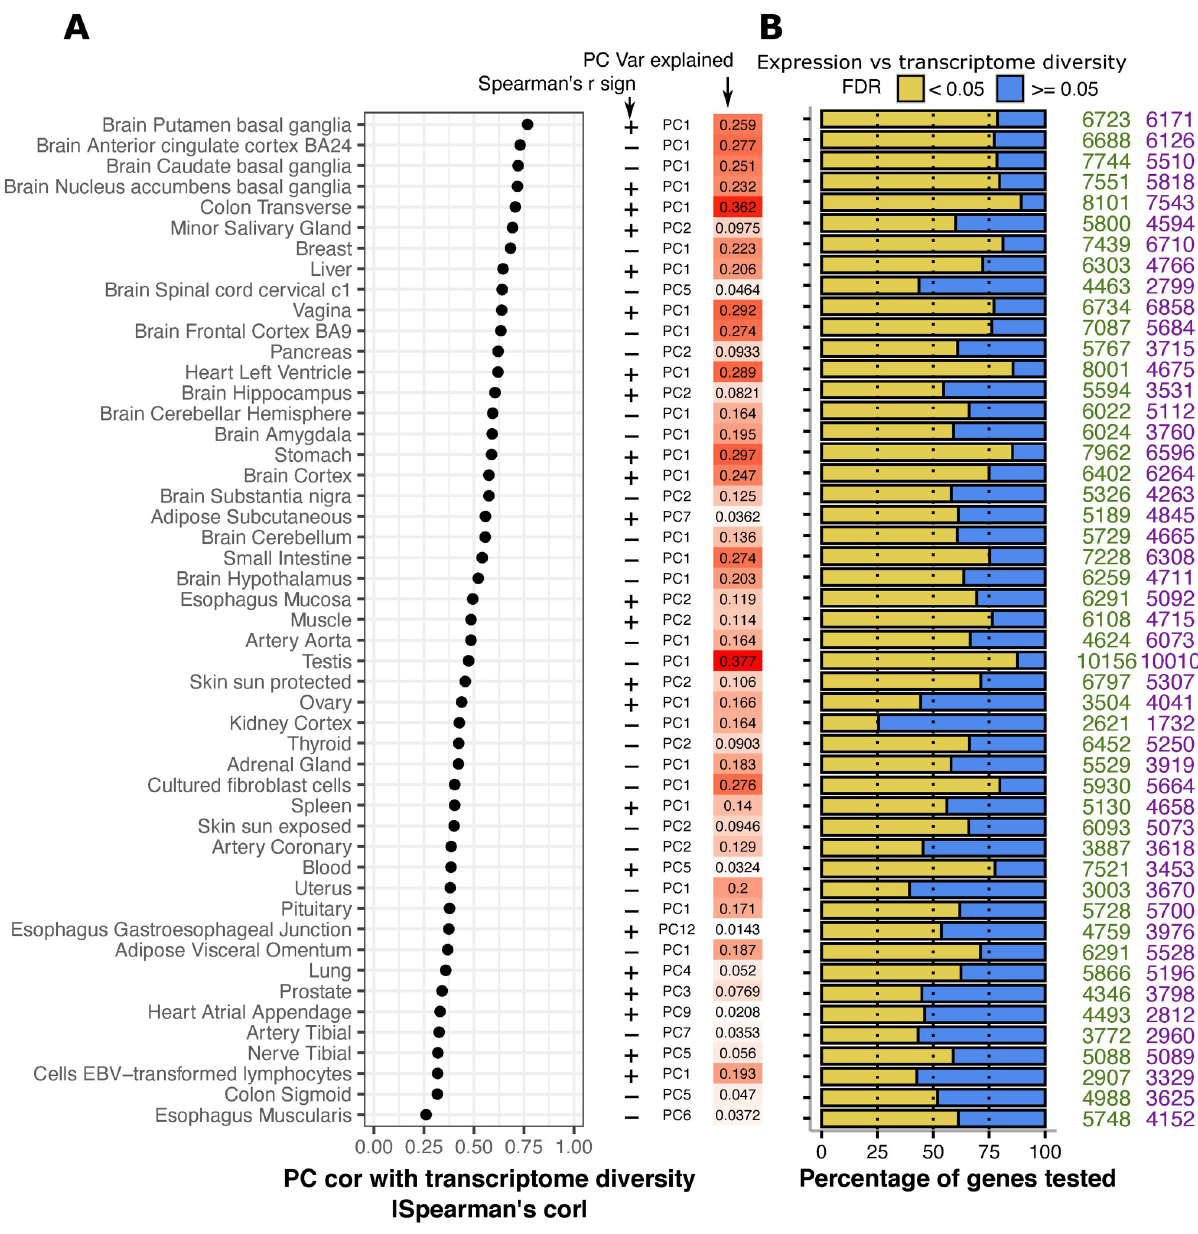
Fig 4. Transcriptome diversity is associated with the expression of most genes across human tissues. A For each GTEx tissue, the dot plot shows the absolute Spearman correlation coefficient between transcriptome diversity values and the loadings of a PC from a PCA performed on the full TMM expression matrix. To the right, the directionality of the correlation is shown (+/-) along with the PC used and its total variance explained. The PC with the highest correlation with transcriptome diversity is shown. Tissues are ordered by absolute Spearman correlation coefficient, and there is no pattern observed when ordered by sample size (Fig B in S1 File). B For each tissue, the percentage of genes whose expression TMM was significantly associated with transcriptome diversity (as in A; BH-FDR < 0.05 in yellow) vs those that were not (BH-FDR > = 0.05 in blue), the numbers on the right represent the directionality of the significant correlations (green are positive significant associations, and purple are negative significant associations). Significance was assessed using a linear regression approach (see Materials and methods: Expression associations with transcriptome